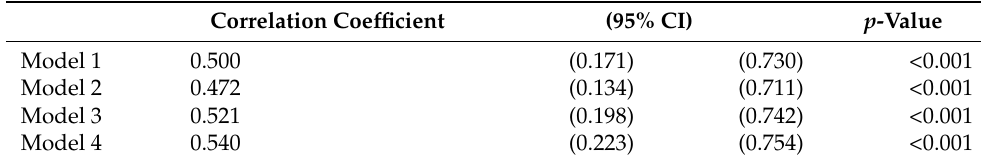
Table 3. Comparison between prediction value and measurement value ( n = 30).